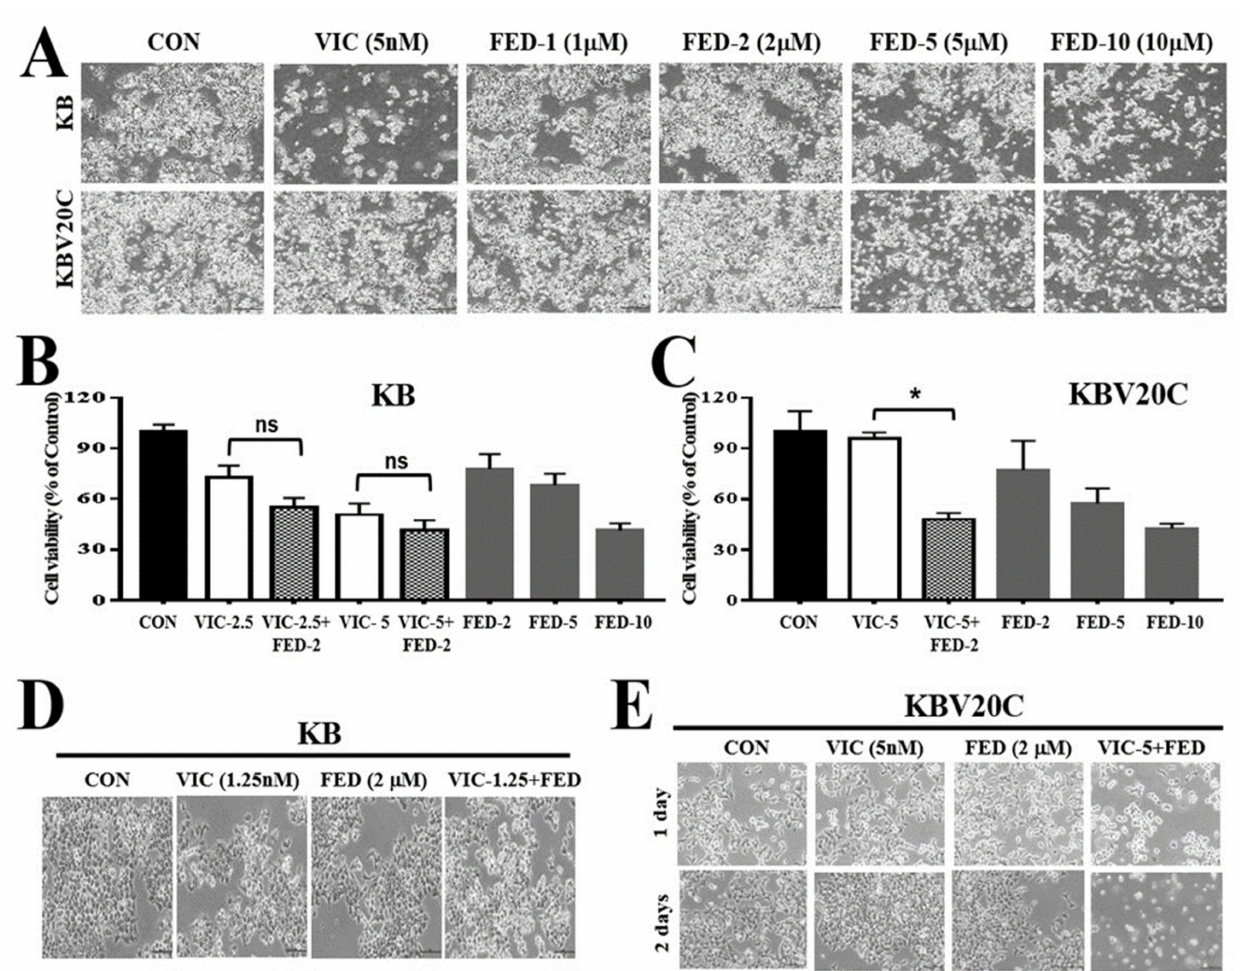
Figure 1. Co-treatment with fedratinib specifically increases the sensitization of drug-resistant KBV20C cancer cells to VIC treatment. ( A ) Parent sensitive KB cells and drug-resistant KBV20C were grown on 60 mm diameter dishes and treated with 5 nM vincristine (VIC), 1 µ M fedratinib (FED-1), 2 µ M fedratinib (FED-2), 5 µ M fedratinib (FED-5), 10 µ M fedratinib (FED-10), or 0.1% DMSO (CON). After 1 day, all cells were observed using an inverted microscope at × 40 magnification. ( B , C ) Parent sensitive KB cells and drug-resistant KBV20C were plated on 96-well plates and grown to 30–40% confluence. The cells were then treated for 48 h with 2.5 nM vincristine (VIC-2.5), 5 nM vincristine (VIC-5), 2 µ M fedratinib (FED-2), 5 µ M fedratinib (FED-5), 10 µ M fedratinib (FED-10), 10 µ M fedratinib (FED-10), 2.5 nM VIC with 2 µ M fedratinib (VIC-2.5 + FED-2), 5 nM VIC with 2 µ M fedratinib (VIC-5 + FED-2), or 0.1% DMSO (CON). Cell viability assay was performed as described in the Materials and Methods. The data are presented as the mean ± SD from two independent experiments repeated in triplicate. For co-treatments, significantly different at * p < 0.05 compared with the corresponding control. The “ns” is an abbreviation of “not significant”. ( D , E ) Parent sensitive KB cells and drug-resistant KBV20C were grown on 60 mm-diameter dishes and treated with 1.25 nM vincristine (VIC-1.25), 5 nM vincristine (VIC-5), 2 µ M fedratinib (FED), 1.25 nM VIC with 2 µ M fedratinib (VIC-1.25 + FED), 5 nM VIC with 2 µ M fedratinib (VIC-5 + FED), or 0.1% DMSO (CON). After 1 day, all cells were observed using an inverted microscope at × 100